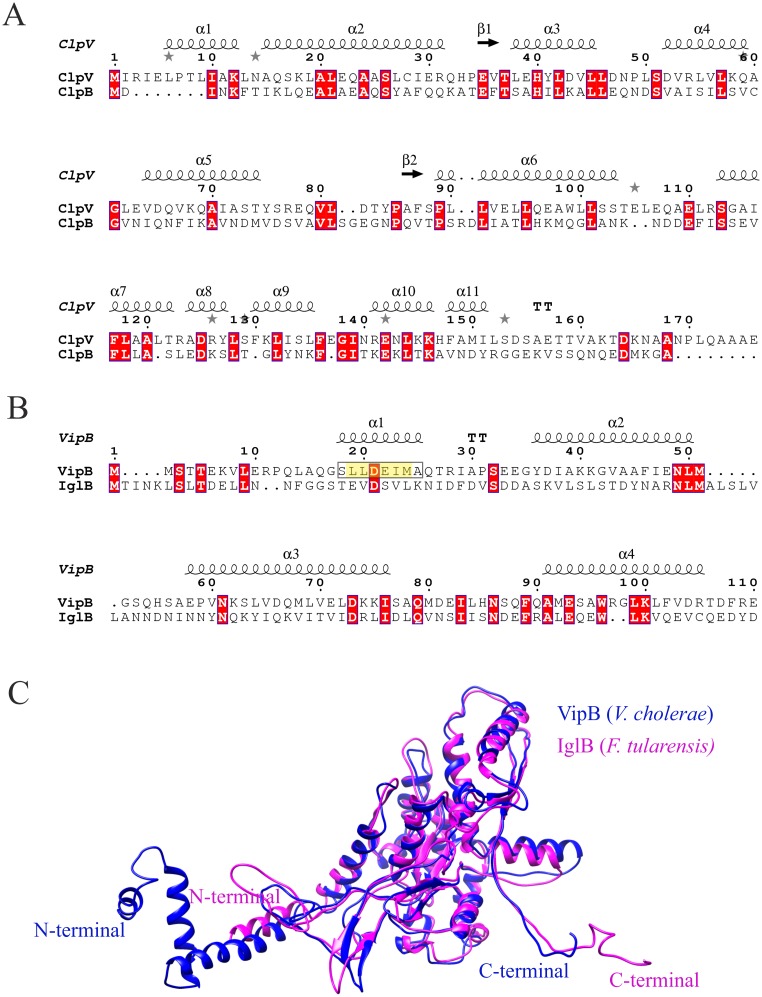
Sequence alignment and structural comparison of the N-terminals of V. cholerae ClpV and VipB with F. tularensis ClpB and IglB.(A). ClpV and ClpB sequences were retrieved from NCBI (https://www.ncbi.nlm.nih.gov/) and sequence alignments were performed using MAFFT (https://mafft.cbrc.jp/alignment/server/), and the corresponding image was generated using the web server ESPript 3 (http://espript.ibcp.fr). The first 174 amino acids (156 for Francisella ClpB) of the N-terminal domain of the ClpV-ClpB alignment is shown. Secondary structures as predicted for V. cholerae ClpV are displayed above the alignment. (B). The VipB and IglB sequences were retrieved from NCBI (https://www.ncbi.nlm.nih.gov/), and essentially the same procedure for alignment was performed as aforementioned. The first 110 amino acids, including the N-terminal domain (1–95 aa), of the VipB-IglB alignment is shown. Secondary structure elements as predicted for V. cholerae VipB are displayed above the alignment. The VipB α-helix known to interact with the ClpV N-terminal is boxed and highlighted in yellow. Conserved consensus sequence residues that contribute to the interaction with the ClpV-N-terminal are boxed and colored in yellow in helix 1. Identical amino acids are highlighted with red color. (C). Ribbon view of the F. tularensis IglB (IglB in pink; PDB: 3j9o) superimposed on the V. cholerae VipB (VipB in blue; PDB: 5mxn).